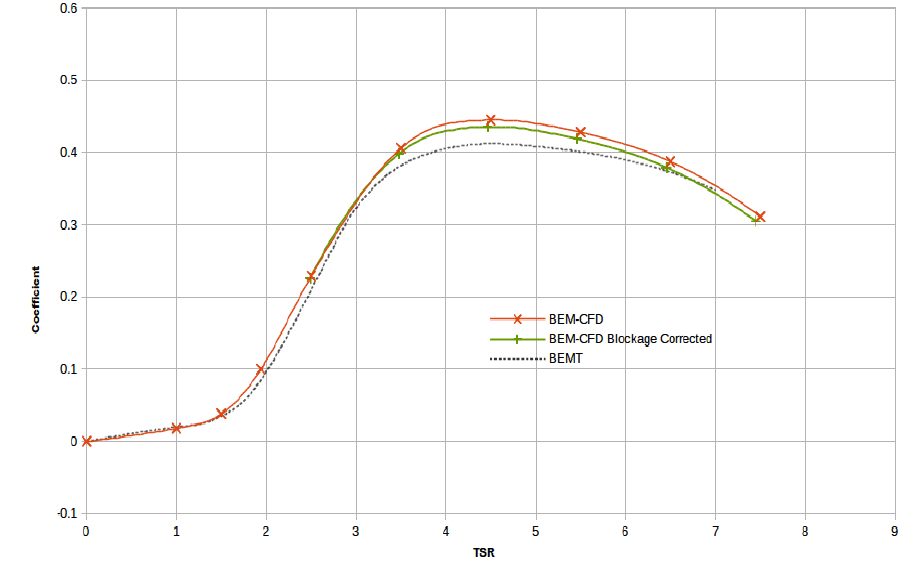
Figure 6. Comparison of IFREMER rotor results for C P (coefficient of power) between BEM-CFD and BEMT for a range of TSRs. Blockage corrected BEM-CFD results are included for